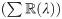
Stability.The sum of the Real components of the eigenvalues of the Jacobian (∑R(λ)) – measuring intrinsic stability of neural dynamics–as a function of structural (DTI) adjacency matrix threshold (%) for patients and controls following Bayesian model averaging. The 90% Bayesian credible intervals are sufficiently small to be contained within the data points.